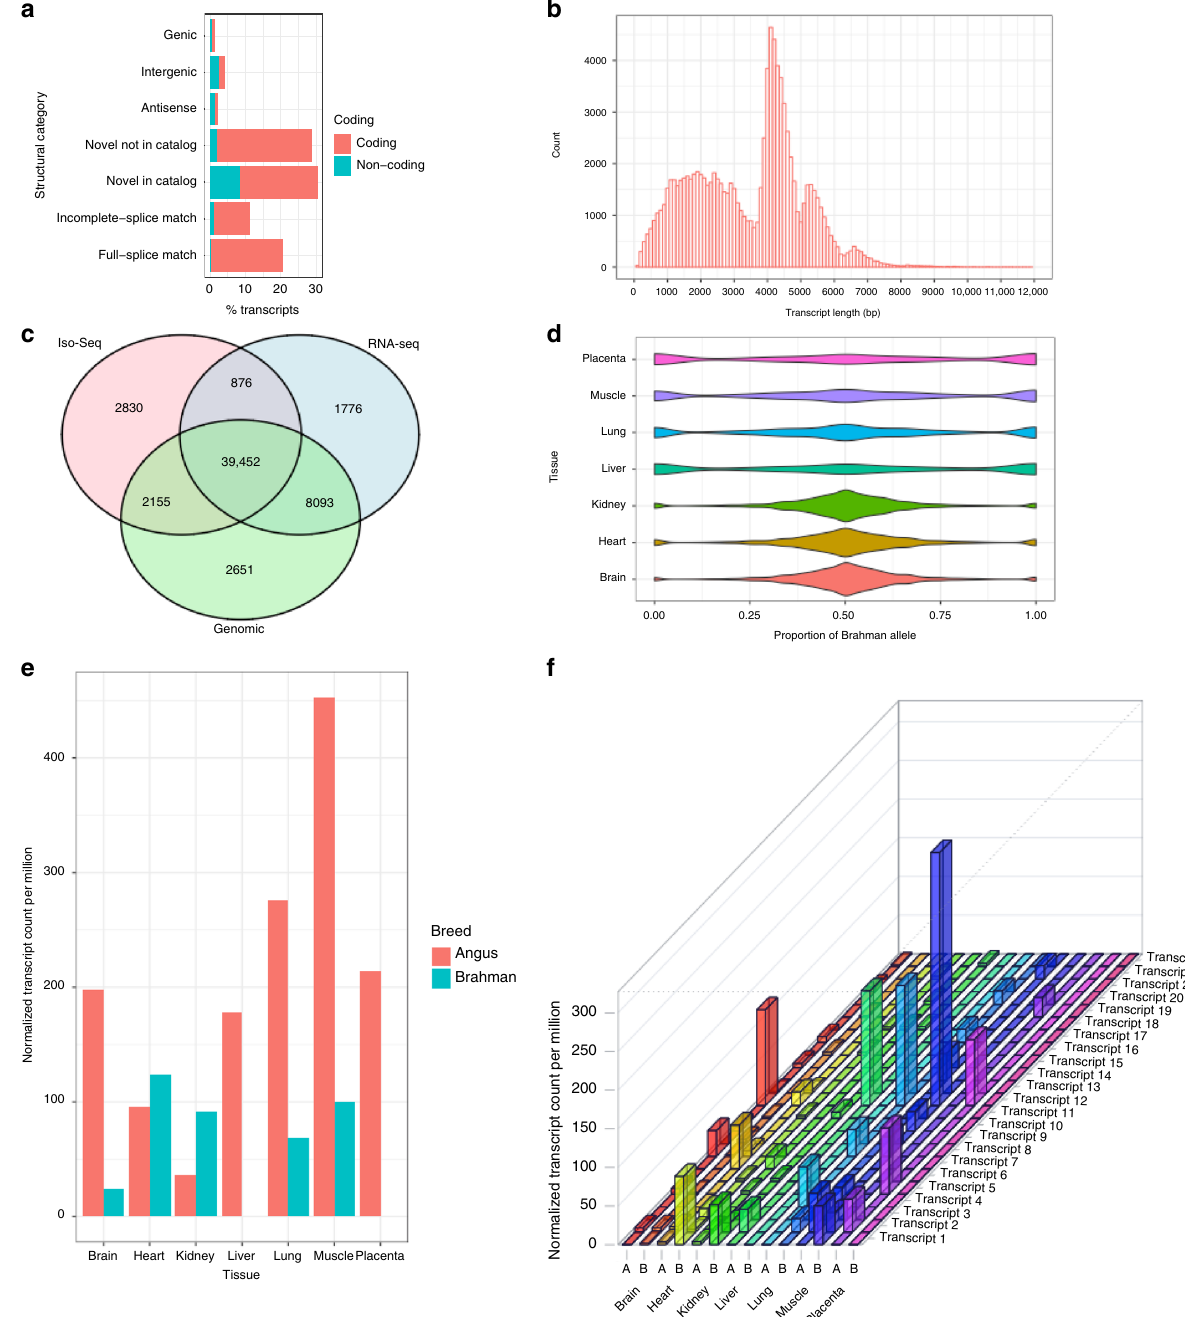
Fig. 6 Phasing of Iso-Seq full-length transcripts in seven tissues reveals transcriptional complexity and allelic imbalance. a Characterization of transcript annotation of the hybrid animal using SQANTI2 against the Brahman annotation. Full-splice match: perfect match with a reference; incomplete- splice match: missing one or more 5 ’ exons against a reference; novel in catalog: novel combinations of known junctions; novel not in catalog: at least one novel splice site. b Histogram of transcript length distribution. c The overlap of SNPs between WGS short reads from genomic DNA, Iso-Seq, and RNA-Seq when Brahman was used as the reference genome. d Violin plot of the proportion of Brahman alleles, which was calculated as the normalized count of Brahman alleles divided by the sum of the normalized count of both Brahman and Angus alleles. Transcripts showing allelic imbalance and with higher expression in Brahman have values closer to 1, whereas those with higher expression in Angus have values closer to 0. e Tissue-speci fi c allelic expression at the gene level for ARIH2 , which is the most highly expressed Angus gene in the brain. f Tissue-speci fi c allelic expression at the transcript level for ARIH2 in the brain, heart, kidney, liver, lung, muscle and placenta. A denotes Angus and B denotes